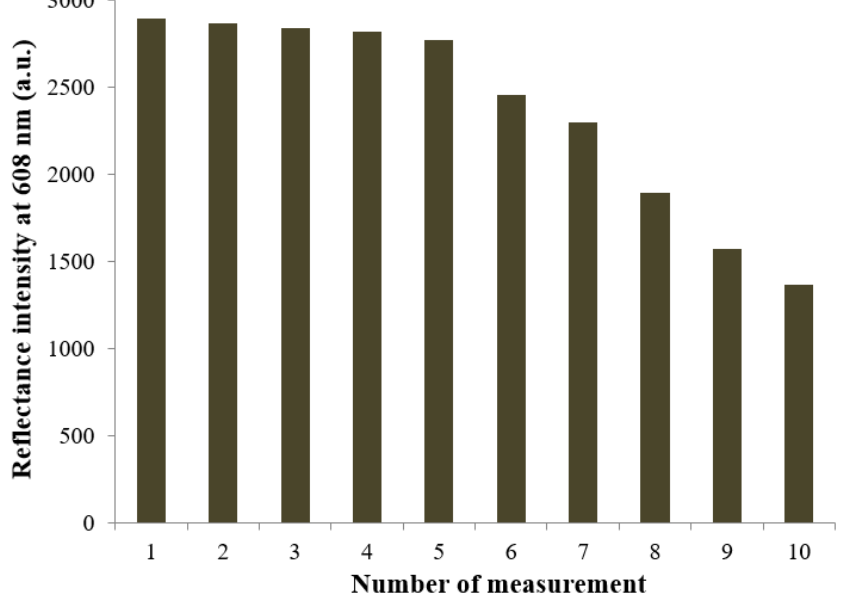
Figure 6. The repeatability performance of the reflectance microbial optosensor at 608 nm, which repeatedly reacted with 20 mg L − 1 nitrite for 4 min after washing the bacterial cells biosensor with 0.1 M K-phosphate buffer at pH 7.0.